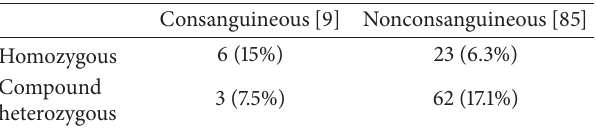
Table 3: Homozygosity versus compound heterozygosity in two